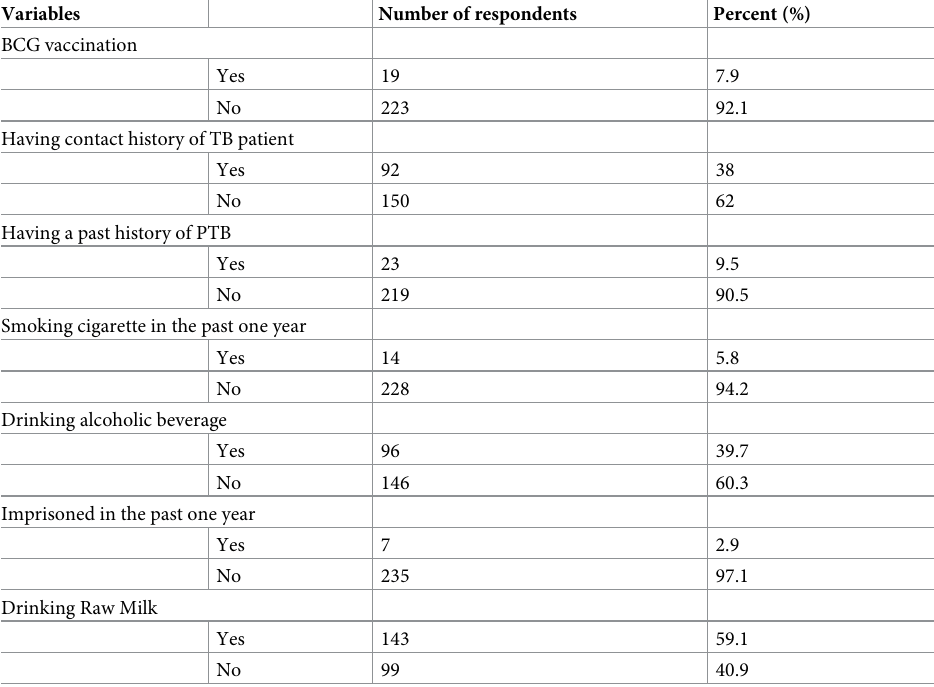
Table 2. Behavioral characteristics of the PTB suspected patients attending Kuyu General Hospital, North Shewa, Oromia, Ethiopia, 2020(n =